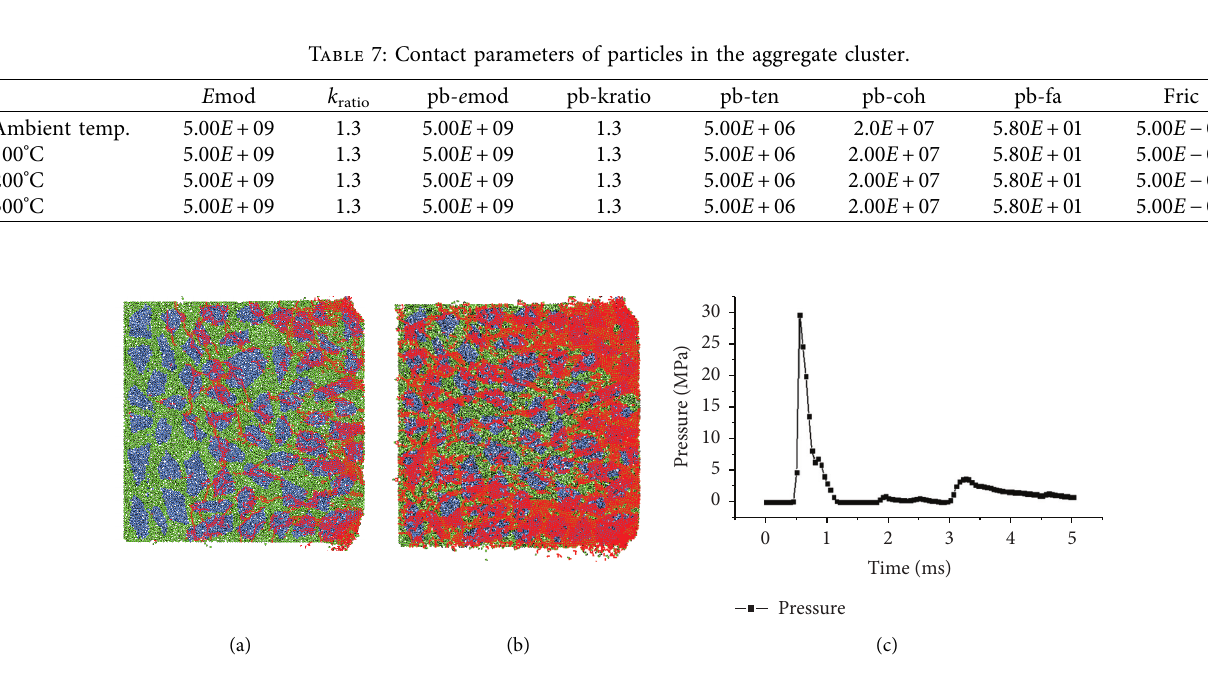
Figure 17: (a) The damage of point B0 at normal temperature, (b) the damage of point B0 at 400K, and (c) the compressive wave.